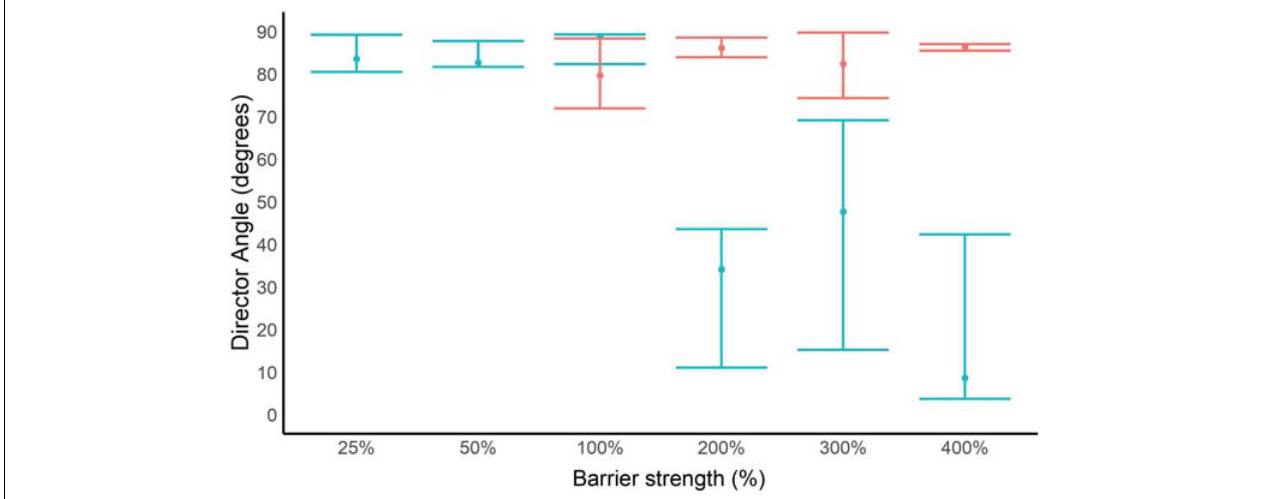
FIGURE 4 | Average and range of director angle values for Procambarus clarkii and Hyalella azteca during stimulus phase for different barrier strengths. Juvenile P. clarkii is displayed in blue, and H. azteca is displayed in